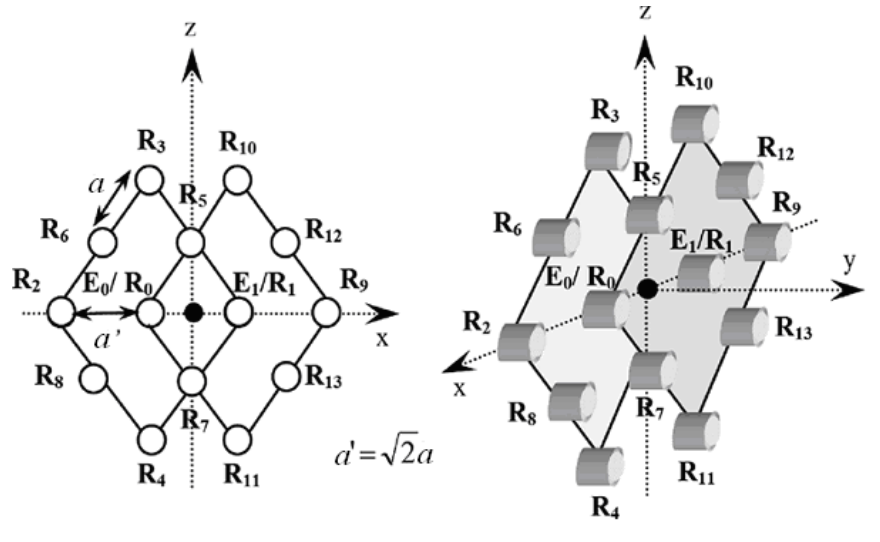
Figure 1. View of sensor structure proposed in